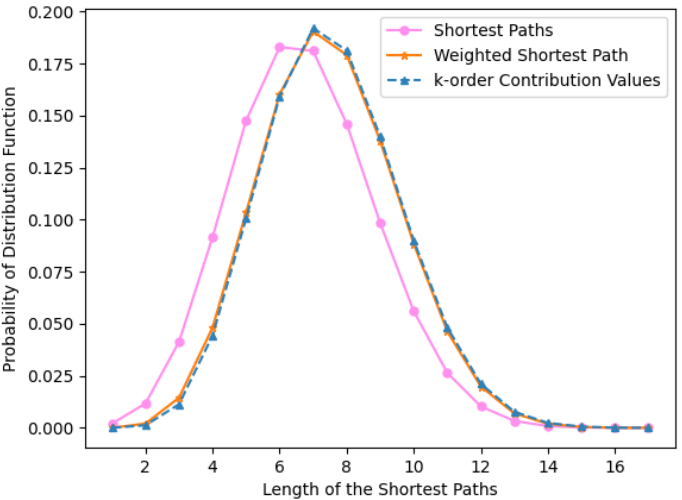
Figure 5. The distribution of weighted shortest path and the k-order contribution value in the Barabási–Albert network with 1000 nodes and one edge to attach from a new node to existing